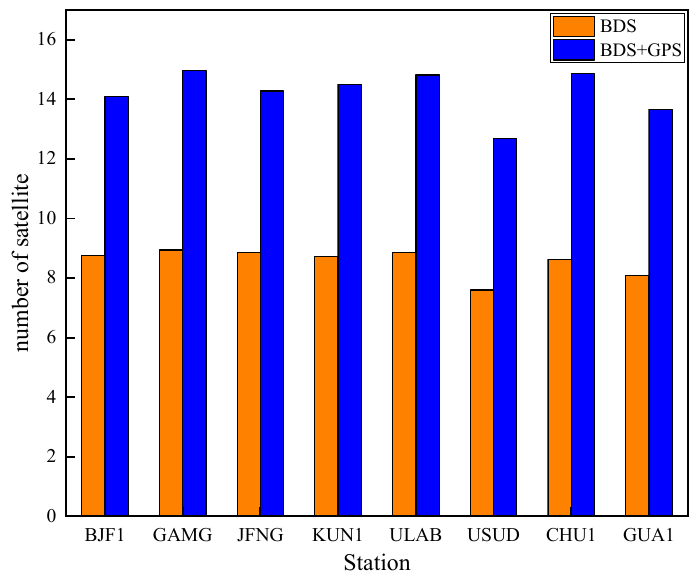
Figure 5. Average number of satellites from DoY 67 to 76 in 2022. As an example, taking station GAMG on DoY 72 in 2022 the static positioning results in the N, E, and U directions (green-N, red-E, and blue-U, respectively) over time are shown in Figure 6, which displays four sequences (BDS B1I/B3I + GPS, BDS B1C/B2a + GPS, BDS B1I/B3I, and BDS B1C/B2a) of static position error in N, E, and U directions from top to bottom. The vertical orange line daily at 0:25 h separates the converged PPP-B2b static positioning results from the non-converged positioning results. The convergent positioning error RMS values in the N, E, and U directions for 2830 epochs of 30 s intervals on DoY 67 in 2022 is calculated. The position error of the four combinations fluctuates within the range of ± 0.05 m after the PPP-B2b static positioning of the GAMG station converges. The position error RMS was about 2 cm for the horizontal component and 4 cm for the vertical component.